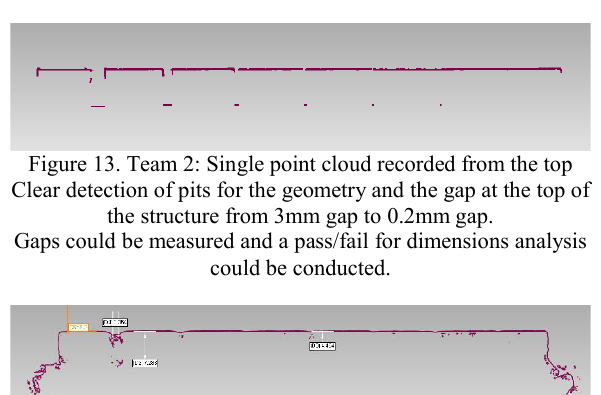
Figure 12. Team 1: point cloud in black, in purple is the as-built geometry in CAD. No gaps could be detected.